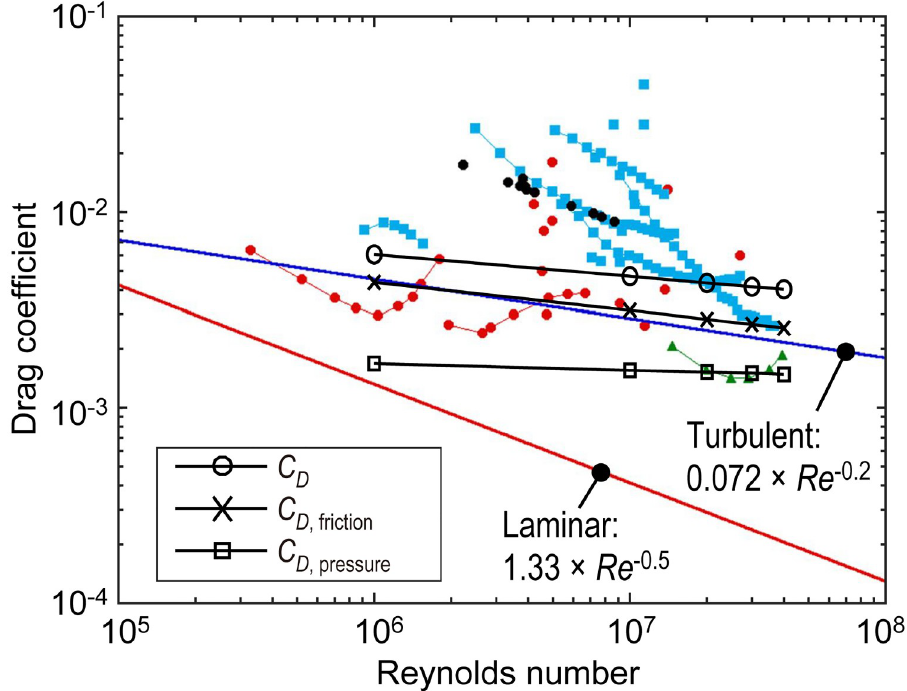
Fig 13. Calculated drag coefficients, C D , (open circles), contribution of friction drag to C D (open diamonds), and contribution of pressure drag to C (open square) against Reynolds number superimposed on the previous data D summarized by Fish (2014) [18]. The blue line represents the frictional drag coefficient for a flat plate with turbulent boundary layer flow, and the red line represents a flat plate with laminar boundary flow. The data were obtained from experiments on rigid models, towed bodies and gliding animals (red solid circles), from hydrodynamic models based on swimming kinematics (blue squares), from a rigid ‘dolphin’ model with the shape of a solid of revolution of the NACA 66 series (green triangles), and from the calculation based on the results of DPIV measurements (black solid circles). The data are from Lang and Daybell (1963) [7]; Lang and Pryor (1966) [15]; Aleyev and Kurbatov (1974) [3]; Kayan (1974) [6]; Purves et al. (1975) [10]; Webb (1975) [11]; Aleyev (1977) [2]; Chopra and Kambe (1977) [4]; Yates (1983) [12]; Videler and Kamermans (1985) [17]; Fish (1998) [5]; and Fish et al. (2014) [18]. � This figure is based on the figure by Fish et al. (2014)